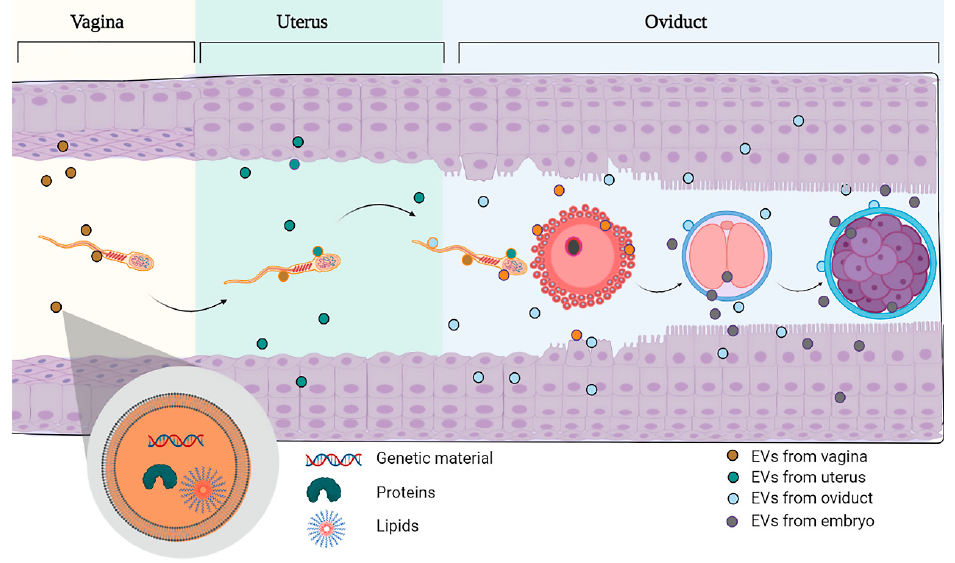
Figure 1. Schematic representation of the sperm travel through the female reproductive tract. Sperm enter in contact with the different extracellular vesicles produced in the vagina, the uterus and the oviduct. Once fertilization takes place, the embryo will come into contact with the EVs produced by the oviduct and the uterus where the embryo and the future fetus will remain for the rest of the pregnancy until delivery. Note that the embryo also produces EVs that allow bidirectional communication with the mother tissue